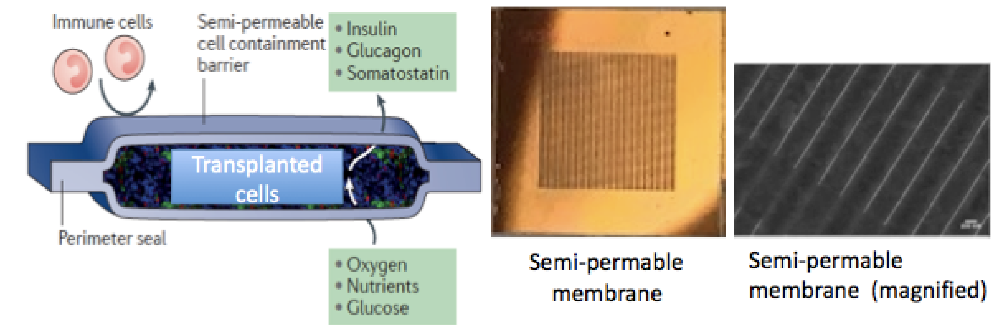
Figure 1. ( Left ): An illustration of an islet encapsulation device [6]; ( Middle ): Semi-permeable silicon membrane; ( Right ): A scanning electron microscope (SEM) image of the membrane surface illustrating slits 2 µ m in length and 7 nm is width (courtesy of Dr.